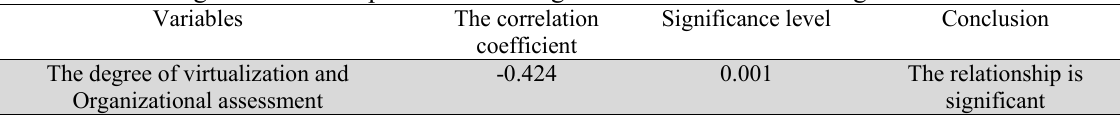
Variables The correlation The degree of virtualization and Organizational assessment